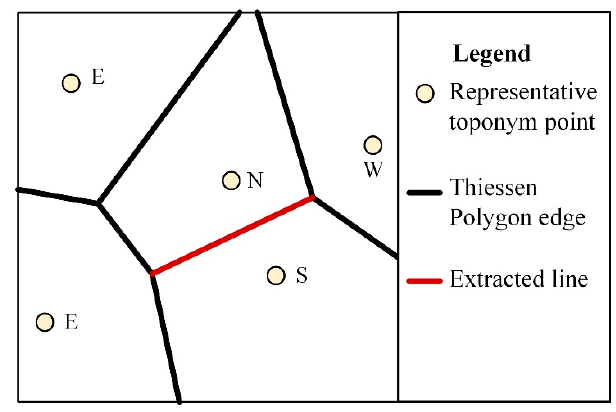
Figure 2. Sketched map of the extraction of Thiessen polygon edges.